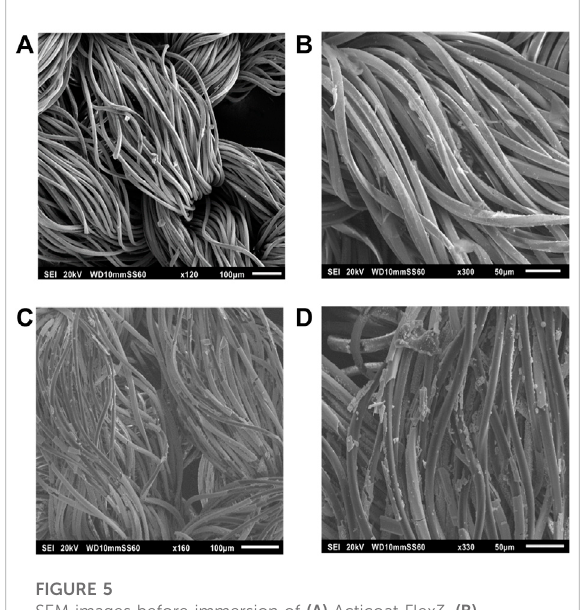
FIGURE 5 SEM images before immersion of (A) Acticoat Flex3, (B) Acticoat Flex7, and after 24 h of immersion in synthetic sweat of (C) Acticoat Flex3 and (D) Acticoat Flex7.